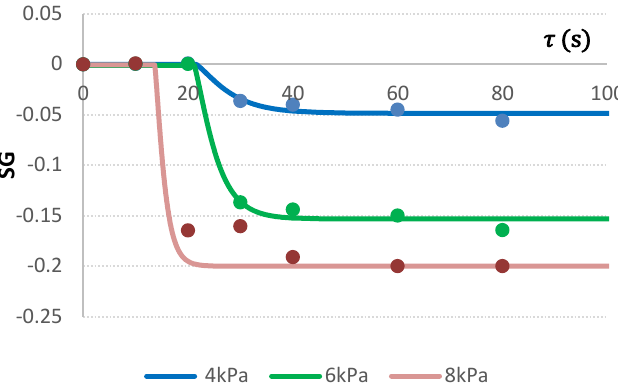
Figure 3. Changes of SG during impregnation of apples at varied vacuum pressures of 4, 6, and 8 kPa using distilled water as the impregnating liquid.